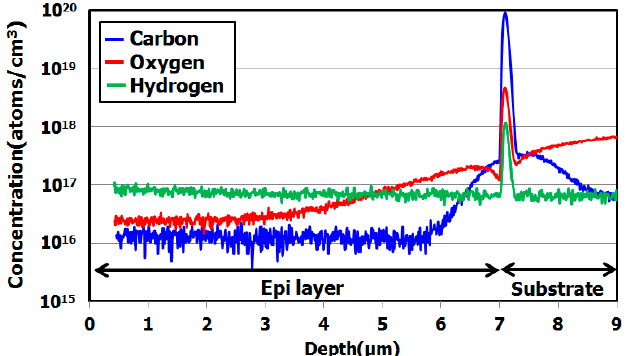
Figure 4. SIMS depth profile of hydrocarbon–molecular–ion–implanted epitaxial silicon wafers. The epitaxial thickness is 7 μ m and hydrocarbon dose amount is 1 × 10 15 cm − 2 . Modified from Kurita et al. [29], Copyright (2016) The Japan Society of Applied Physics.